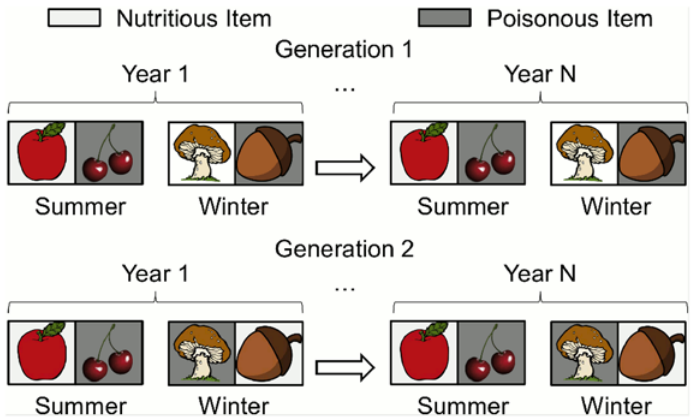
Fig 3. Randomizing food associations between generations. To ensure that agents learn associations within their lifetimes instead of genetically hardcoding associations, whether each food item is nutritious or poisonous is randomized each generation. There are four food items per season (two are